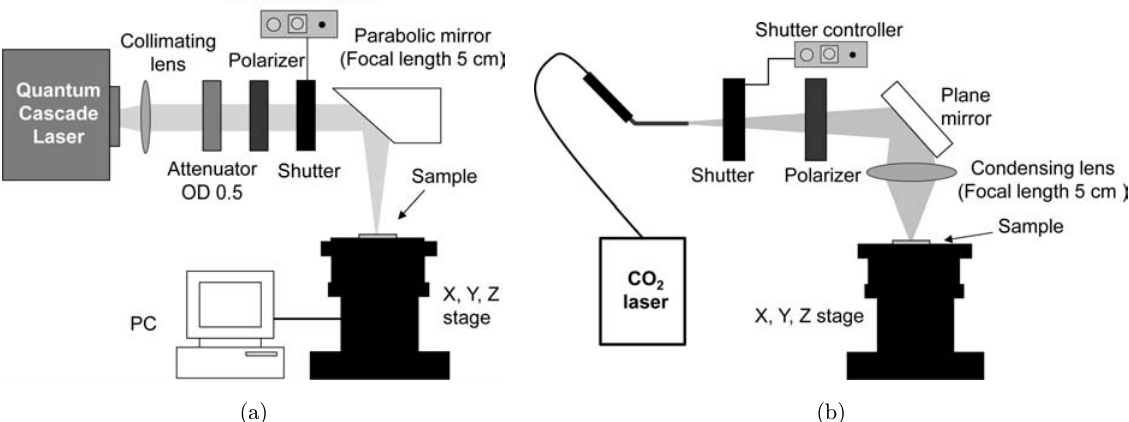
Fig. 2. Optical setup used for QCL and CO 2 laser